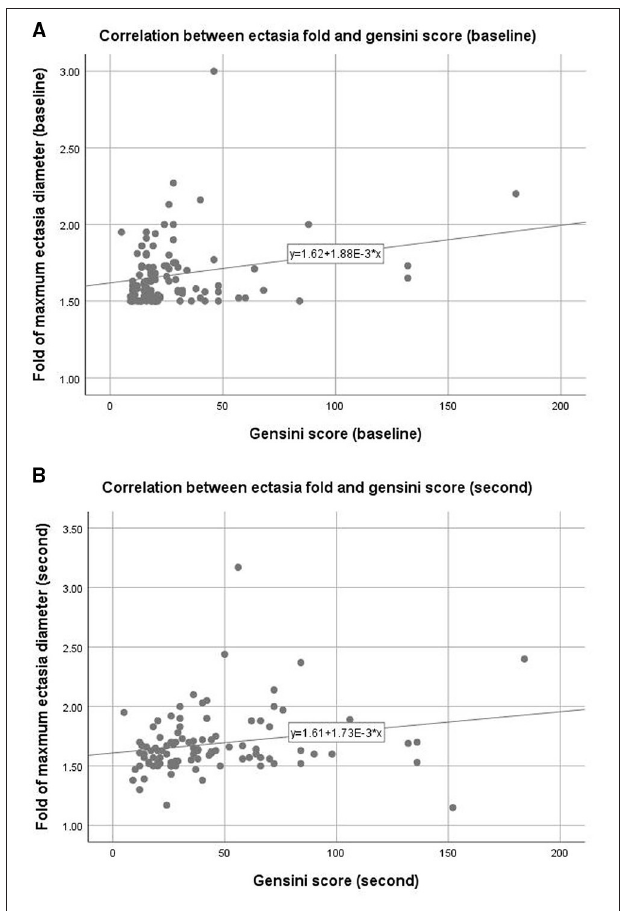
FIGURE 2 | Correlation between coronary ectasia and stenosis. Upper panel (A) : Baseline data measured from the first coronary angiogram, Pearson correlation coefficient = 0.227, p = 0.024, R 2 = 0.048. Lower panel (B) : follow-up data measured from the second coronary angiogram, Pearson correlation coefficient = 0.214, p = 0.033, R 2 = 0.072.